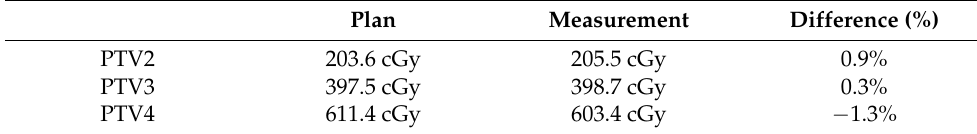
Table 1. Dose differences between plan and measurement by ion